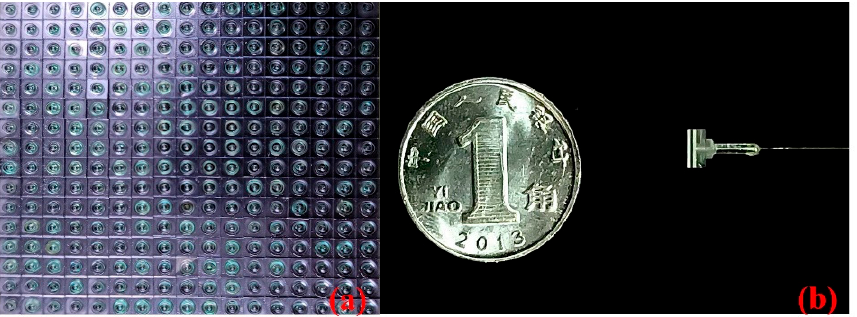
Figure 5. The diagram of finished sensors: ( a ) mass-produced sensitive units of the sensor, and ( b ) the fiber-optic Fabry–Perot sensor.